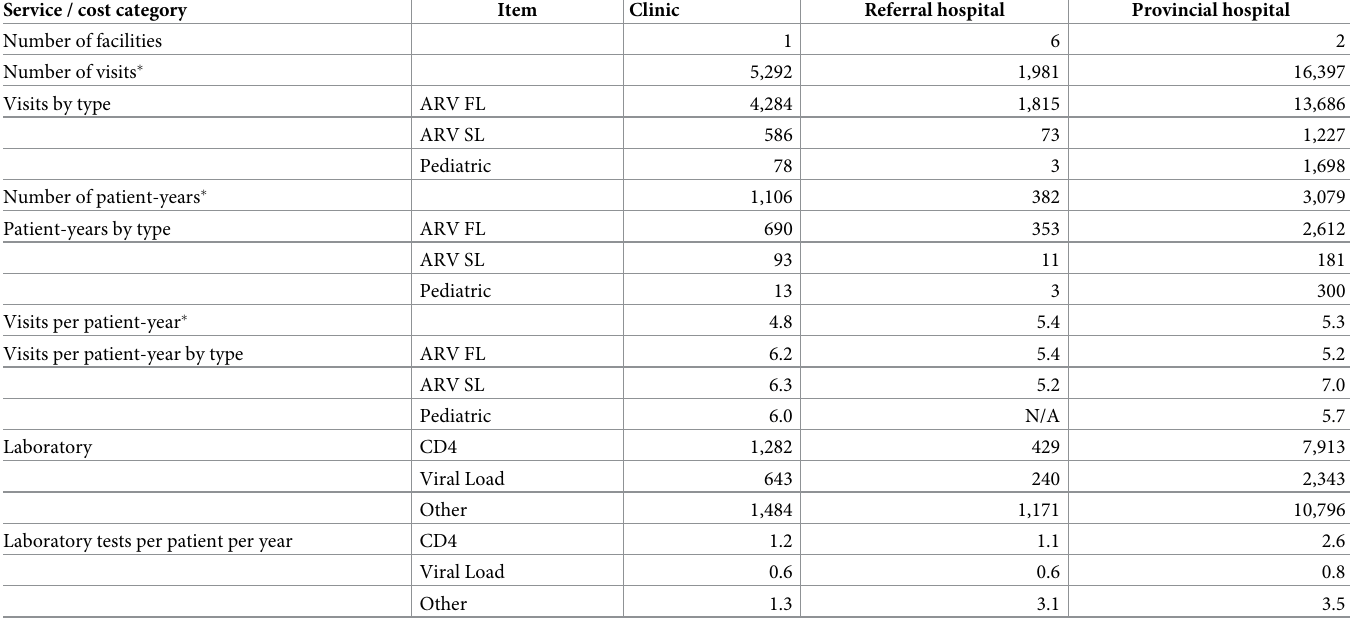
Abbreviations: ART, Antiretroviral Therapy; ARV, Antiretroviral Drug; FL, First Line; SL, Second Line. � Includes patients on